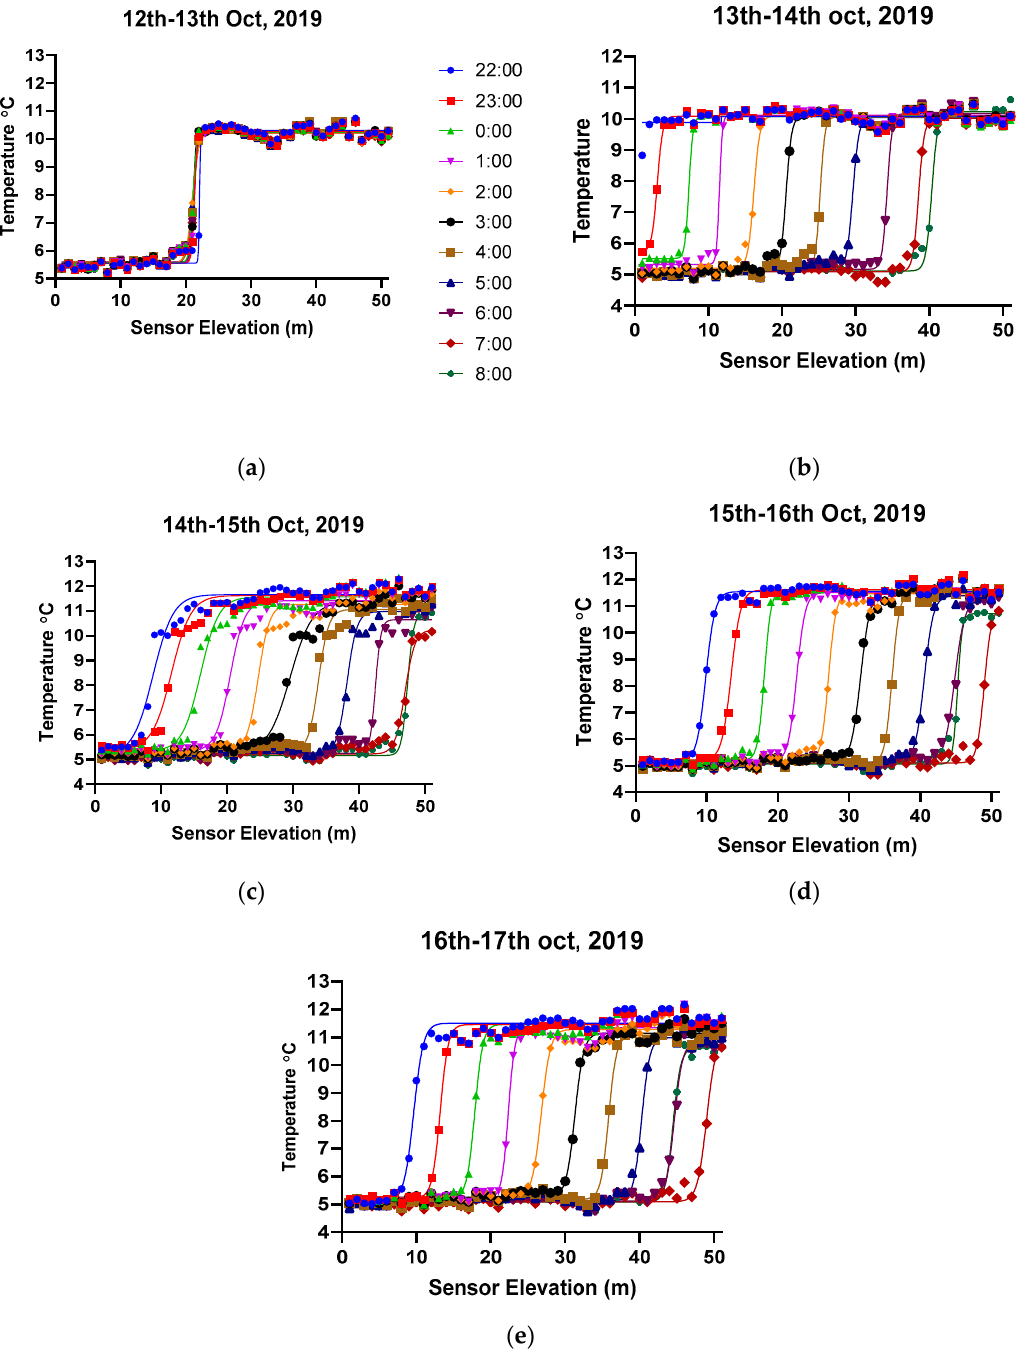
Figure 4. Temperature distribution plot for 12th–17th of October 2019 on GraphPad prism software. Figure4. Temperaturedistributionplotfor12th–17thof October 2019onGraphPadprismsoftware( a – e ( a – e ).